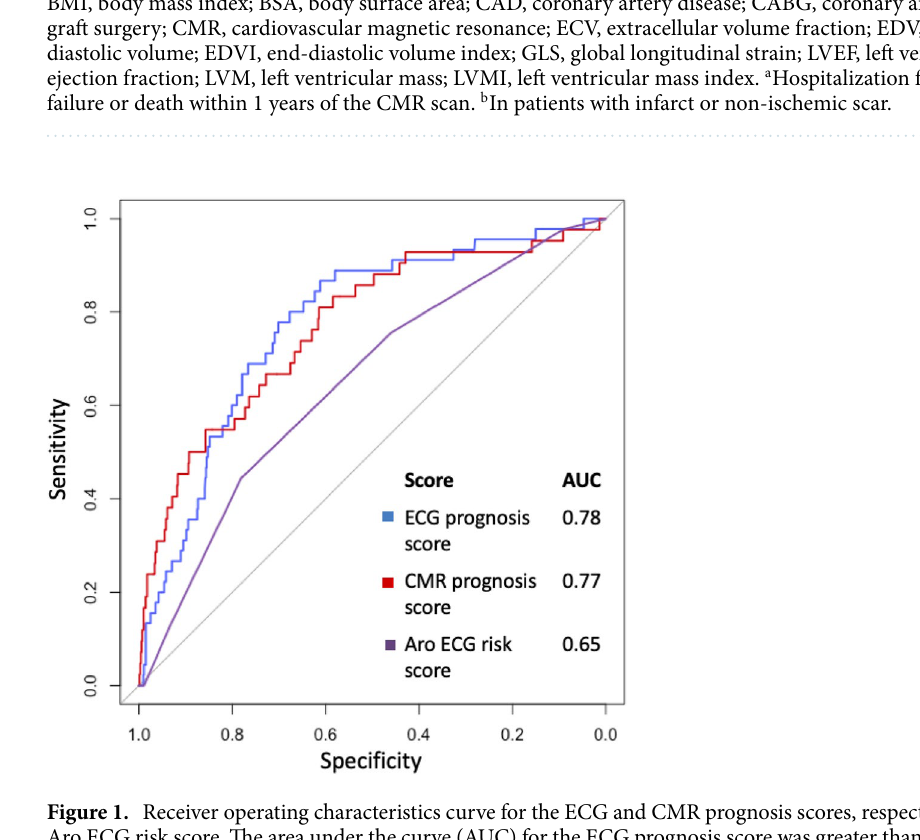
Table 1. Baseline characteristics for the study population. Significant values are in bold. Continuous data are given as median [interquartile range], or number (%) and analyzed with Mann-Whitey U test or Chi-square, respectively. ACEi indicates angiotensin-converting enzyme inhibitors; ARB, angiotensin II receptor blocker; BMI, body mass index; BSA, body surface area; CAD, coronary artery disease; CABG, coronary artery bypass